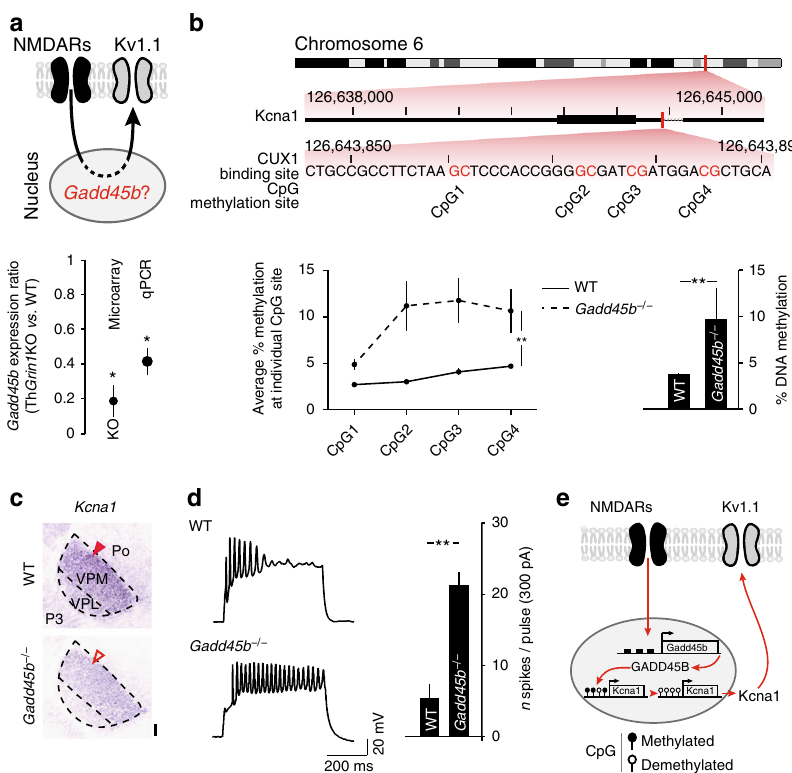
Fig. 3 GADD45B epigenetically regulates Kv1.1 expression. a Top: working hypothesis. Bottom: Gadd45b expression is decreased in Th Grin1 KO VPM neurons. Student ’ s t -test, * P < 0.05, ** P < 0.01. b DNA methylation of the Kcna1 promoter region is increased in Gadd45b − / − VPM neurons. Top: schematic representation of the Kcna1 promoter region. Bottom: bisul fi te sequencing results. Kruskal – Wallis test, ** P < 0.01. c In situ hybridization shows decreased Kcna1 expression in Gadd45b − / − VPM ( n = 3). Red arrowheads show the labeling in VPM. Scale bar: 100 μ m. d Gadd45b − / − VPM neurons